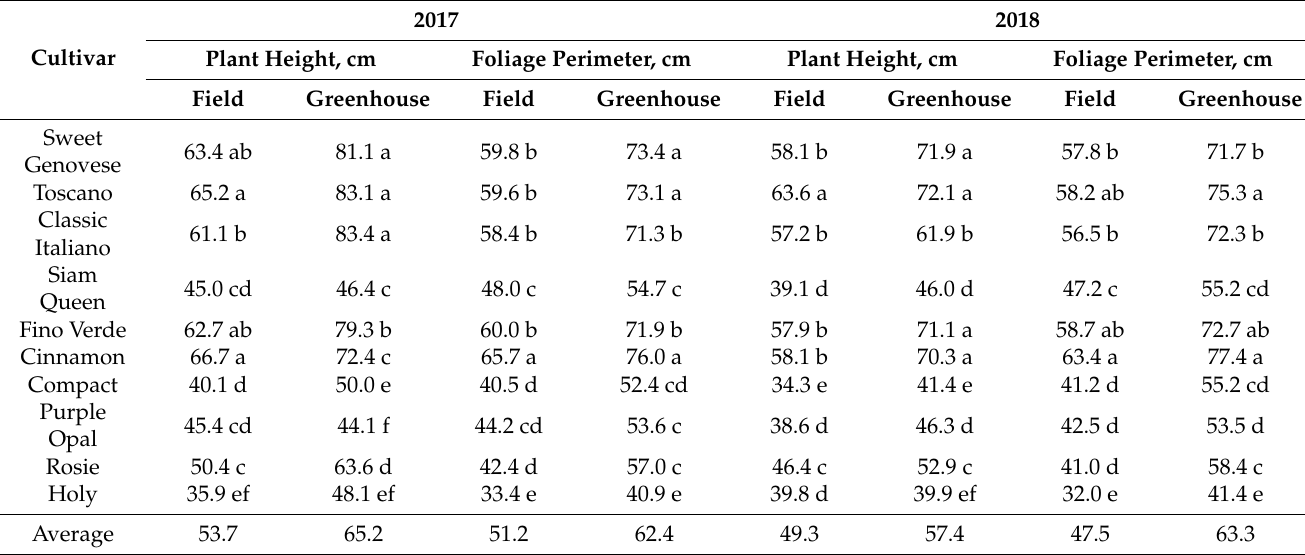
Table 2. Morphological parameters of basil foliage in 2017 and